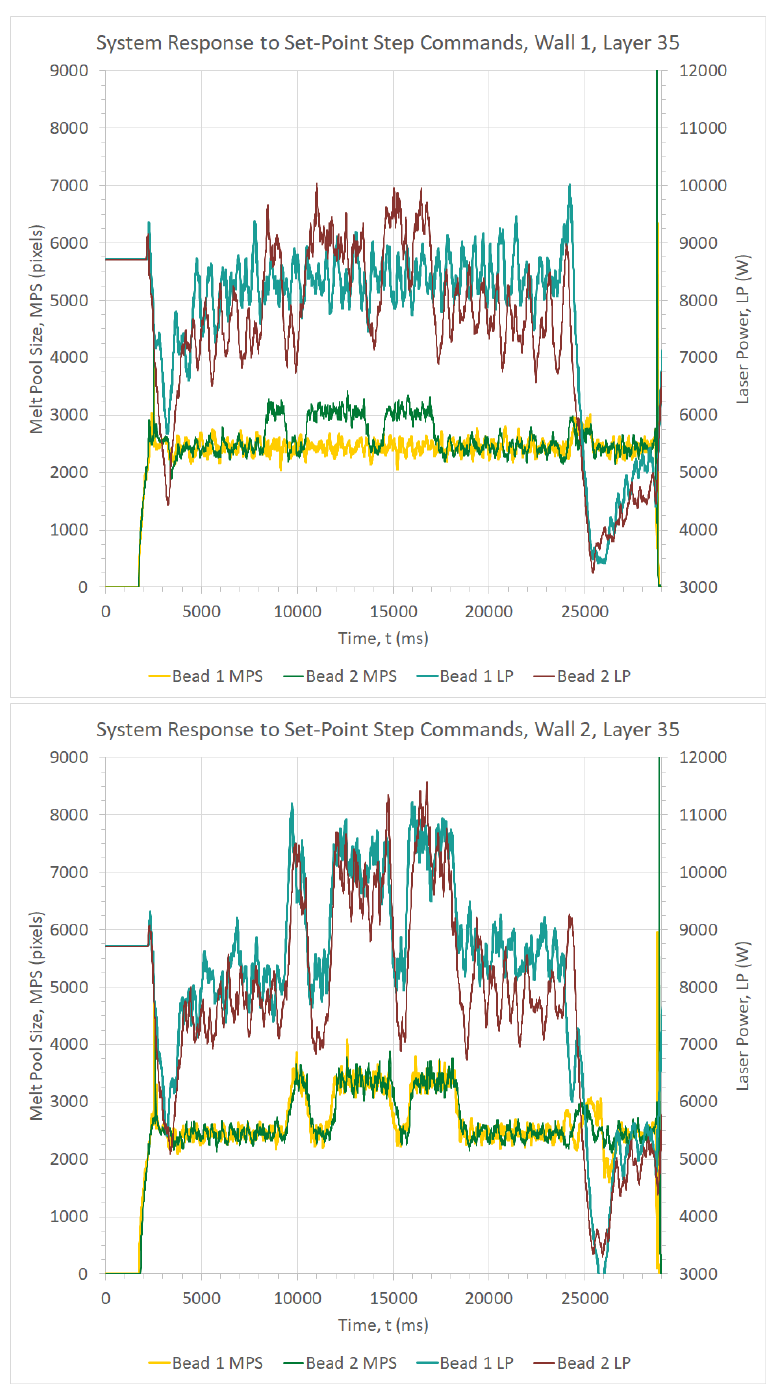
Figure 7. Laser power and melt pool size response for layer 35.